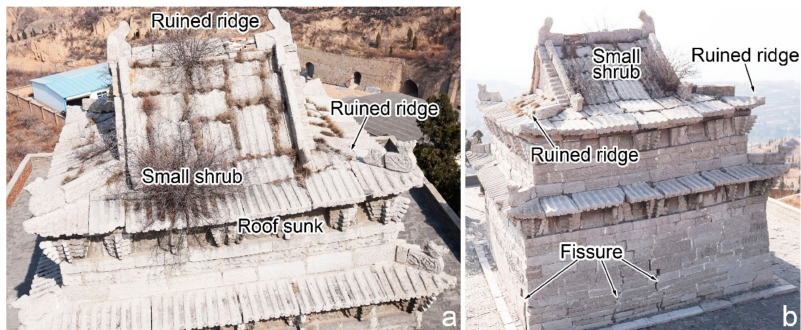
Figure 16. Damage conditions of limestone hall at present. ( a ) Ridge damage in the south and roof sedimentation; ( b ) Northern roof sedimentation and crack on the